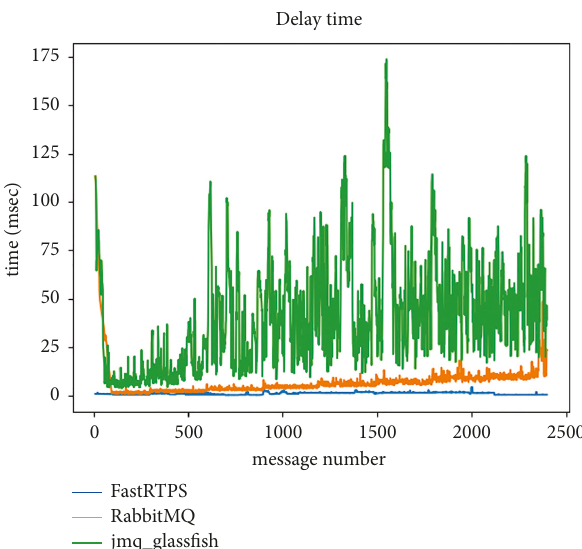
Figure 12: FastRTPS’s, RabbitMQ’s, GlassFish’s latency with a frequency of 1000 messages per second and different message sizes.